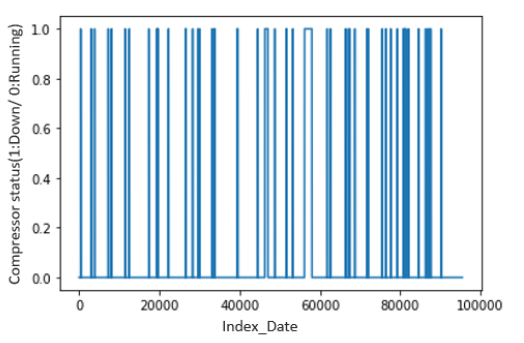
Figure 7. Compressor status: running and down .